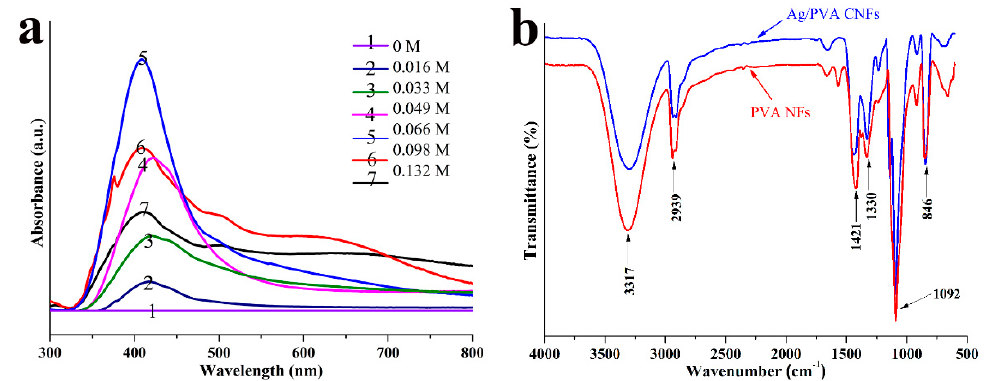
Figure 5. ( a ) UV-vis spectra of Ag/PVA CNFs prepared with different AgNO 3 concentrations, ( b ) FTIR spectra of PVA NFs and Ag/PVA CNFs prepared with AgNO 3 concentration of 0.066 mol/L.